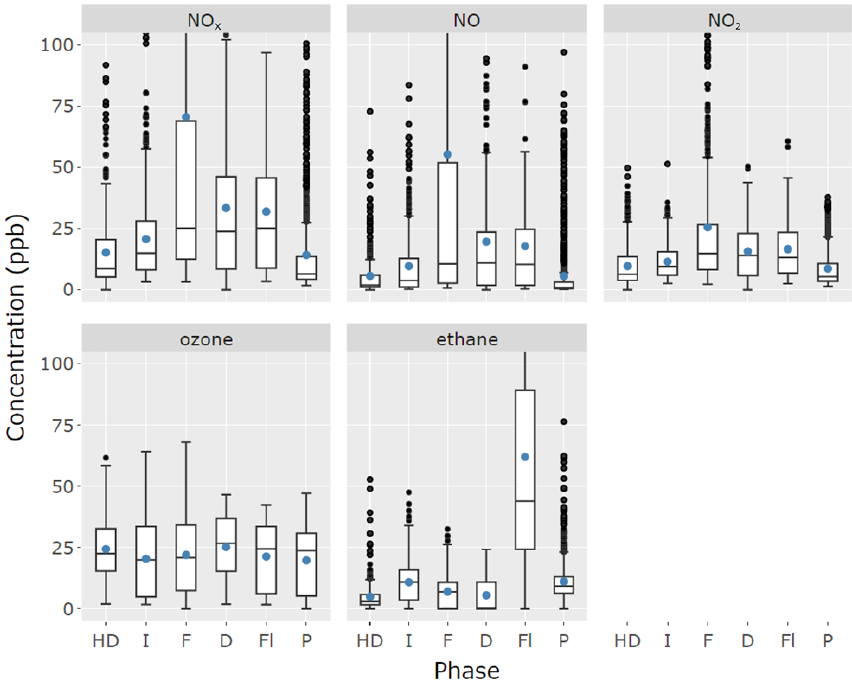
Figure 3. Summary statistics of input parameters for (a) NO x , (b) NO, (c) NO 2 , (d) ozone, and (e) ethane (HD: horizontal drilling; I: idle; F: fracturing; D: drillout; Fl: flowback; P: production). The idle phase consists of gaps of time between other operational phases, when there was little to no emissions-generating activity on the well